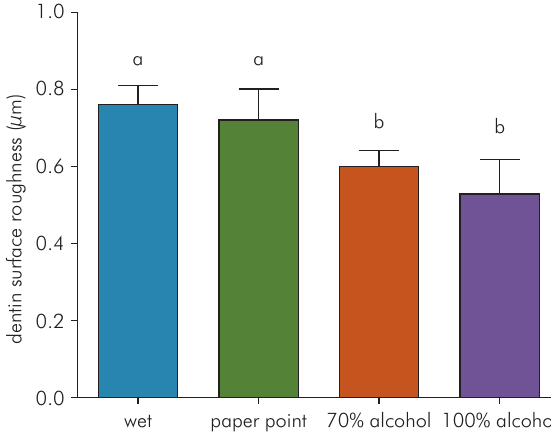
Figure 2. Dentin surface physicochemical properties and interaction with AH Plus. Dentin surface roughness.